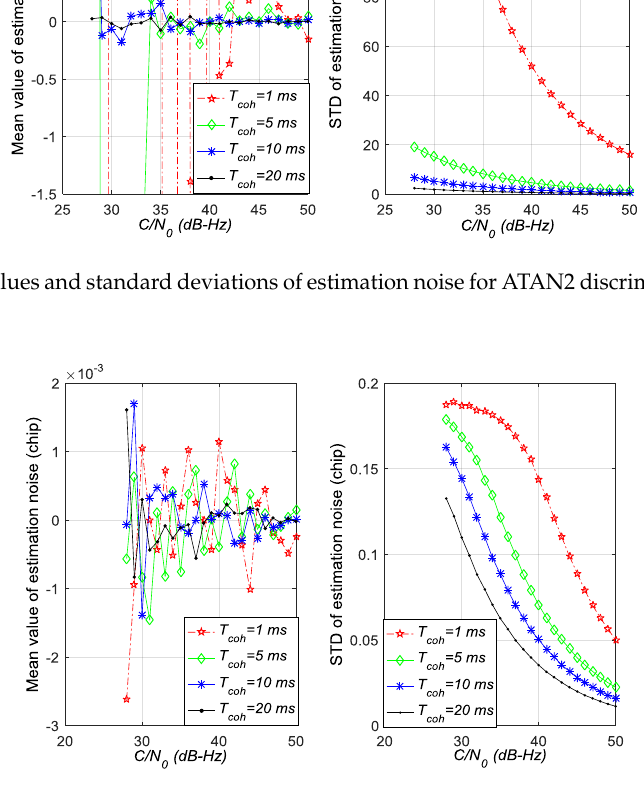
Figure 7. Mean values and standard deviations of estimation noise for NC-EMLE discriminator in different C / N 0 and T coh ( d = 1 chip).